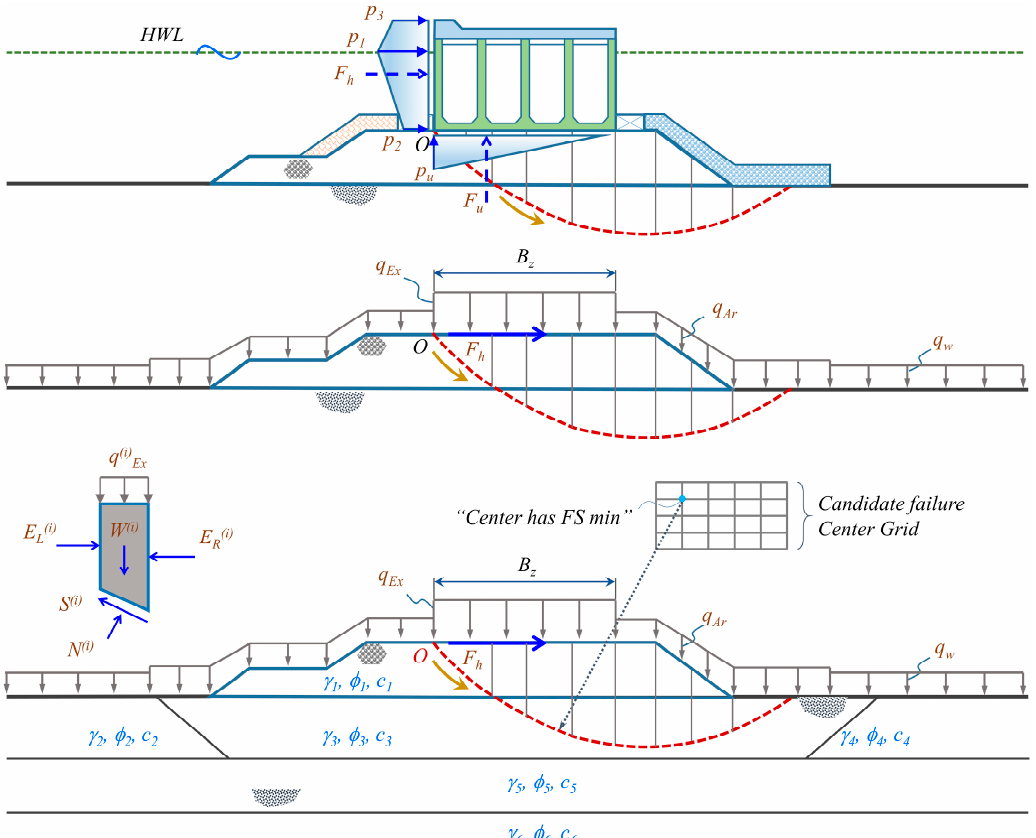
Figure 10. Mechanism applied to estimate the PF against bearing capacity using a combination of Bishop’s simplified method and MCS.